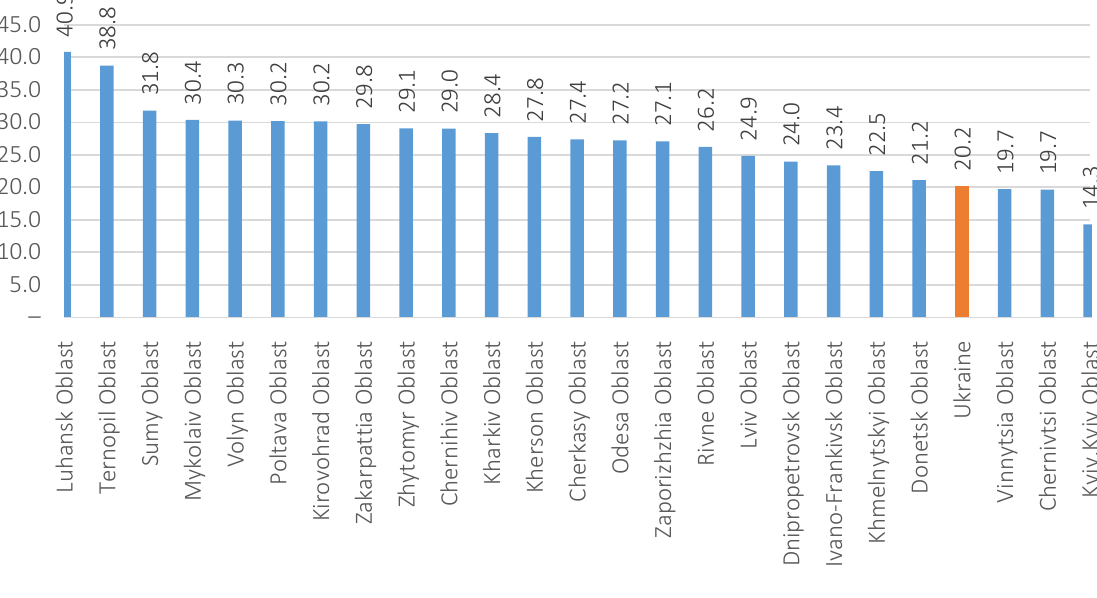
Figure 5. Growth of deposits attracted by deposit corporations (except for the National Bank of Ukraine) across regions, February 2020–February